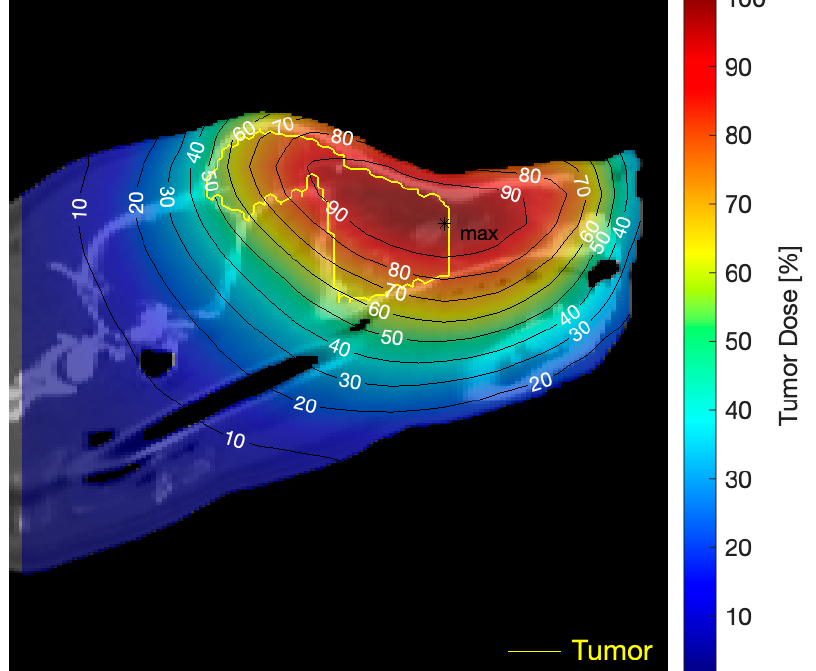
Figure 4. Example of tumor dose distribution (for Senshi, in this case) as a result of a three-portal irradiation per BNCT application employing the B2 beam. Tumor dose isocurves are overlaid onto a sagittal plane of the CT study.